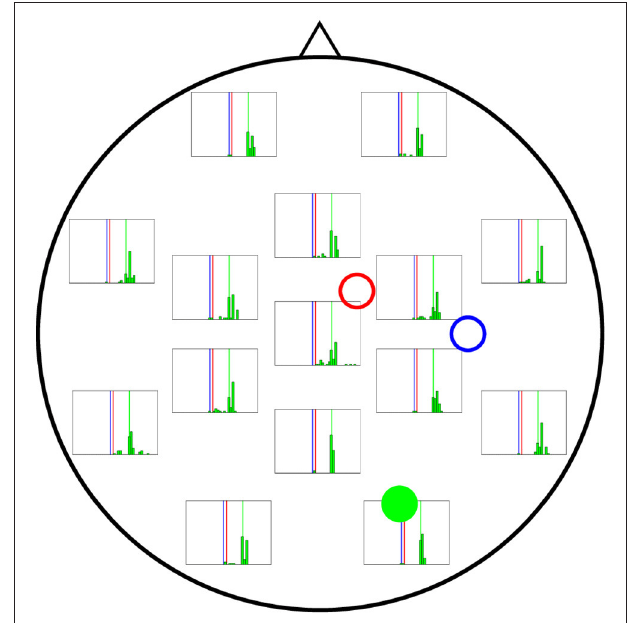
FIGURE 7 | Distribution of 50 realisations of A estimations from a single electrode for cortical column 2 (solid green circle). The distributions here are wider than for A 1 and A 3 , although they still tend to be more accurate near the cortical column (solid green circle) and group around the target value of A 2 10.00 mV (vertical green =